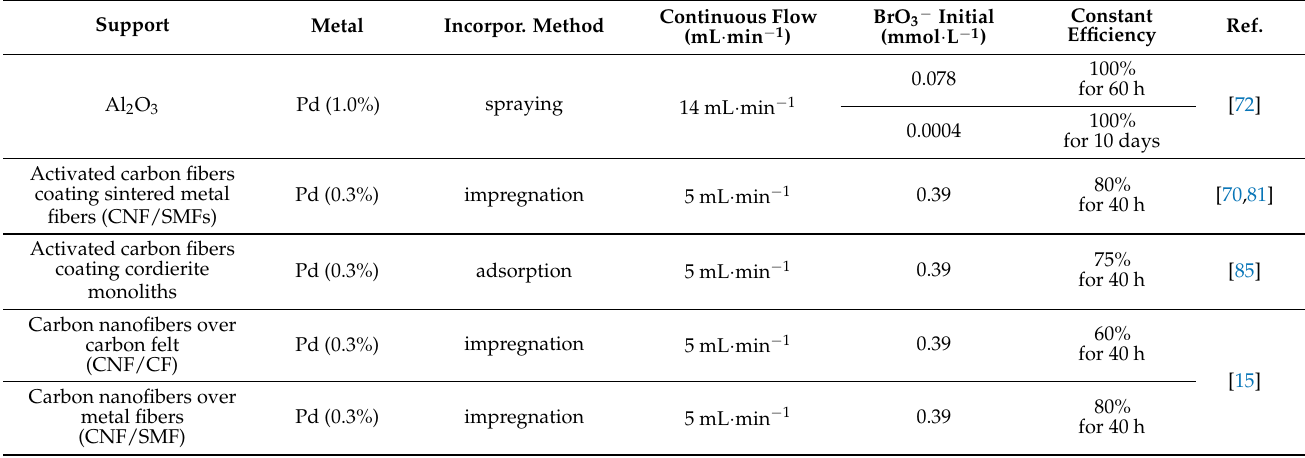
Table 2. Summary of the catalysts used for the bromate hydrogenation reaction at room temperature (22–27 ◦ C) and atmospheric pressure using continuous